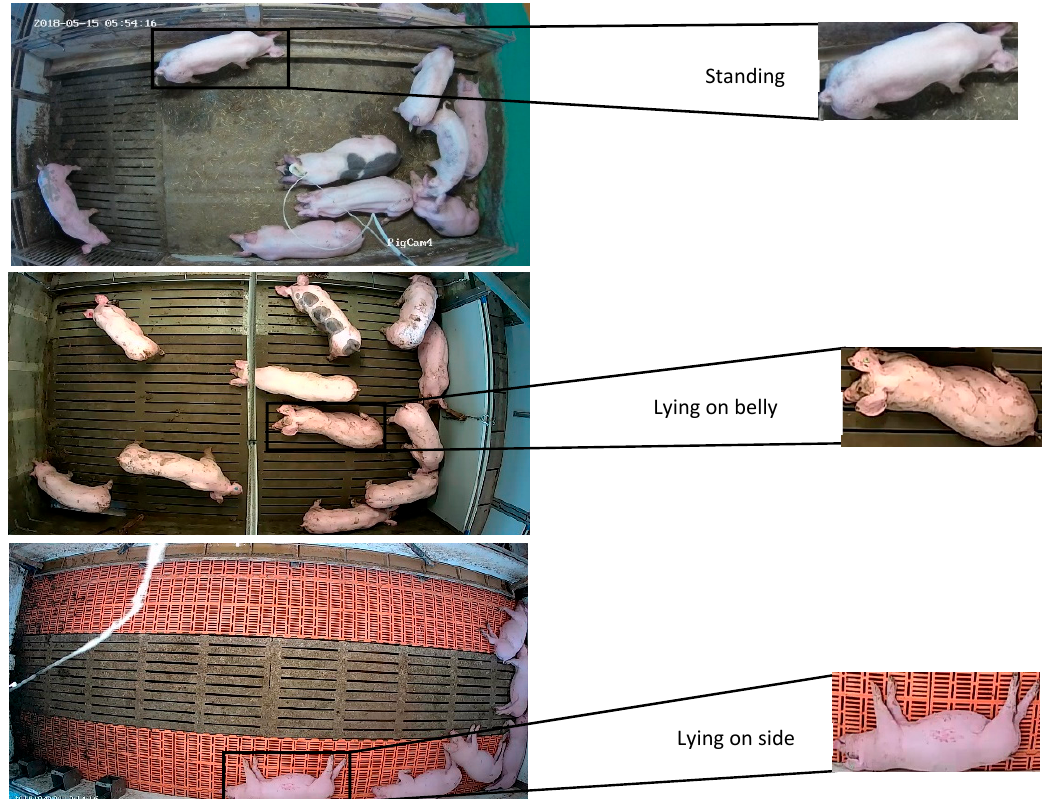
Figure 2. Examples of three posture classes used in this study in different farming conditions.